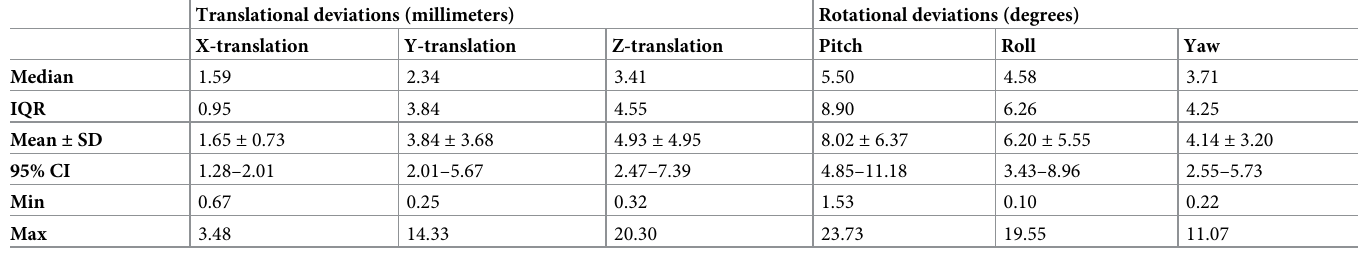
Table 1. Absolute translational and rotational deviations between the planned cochlear implant (CI) and the implanted CI calculated with the Iterative Closest Point (ICP) algorithm. Translational deviations